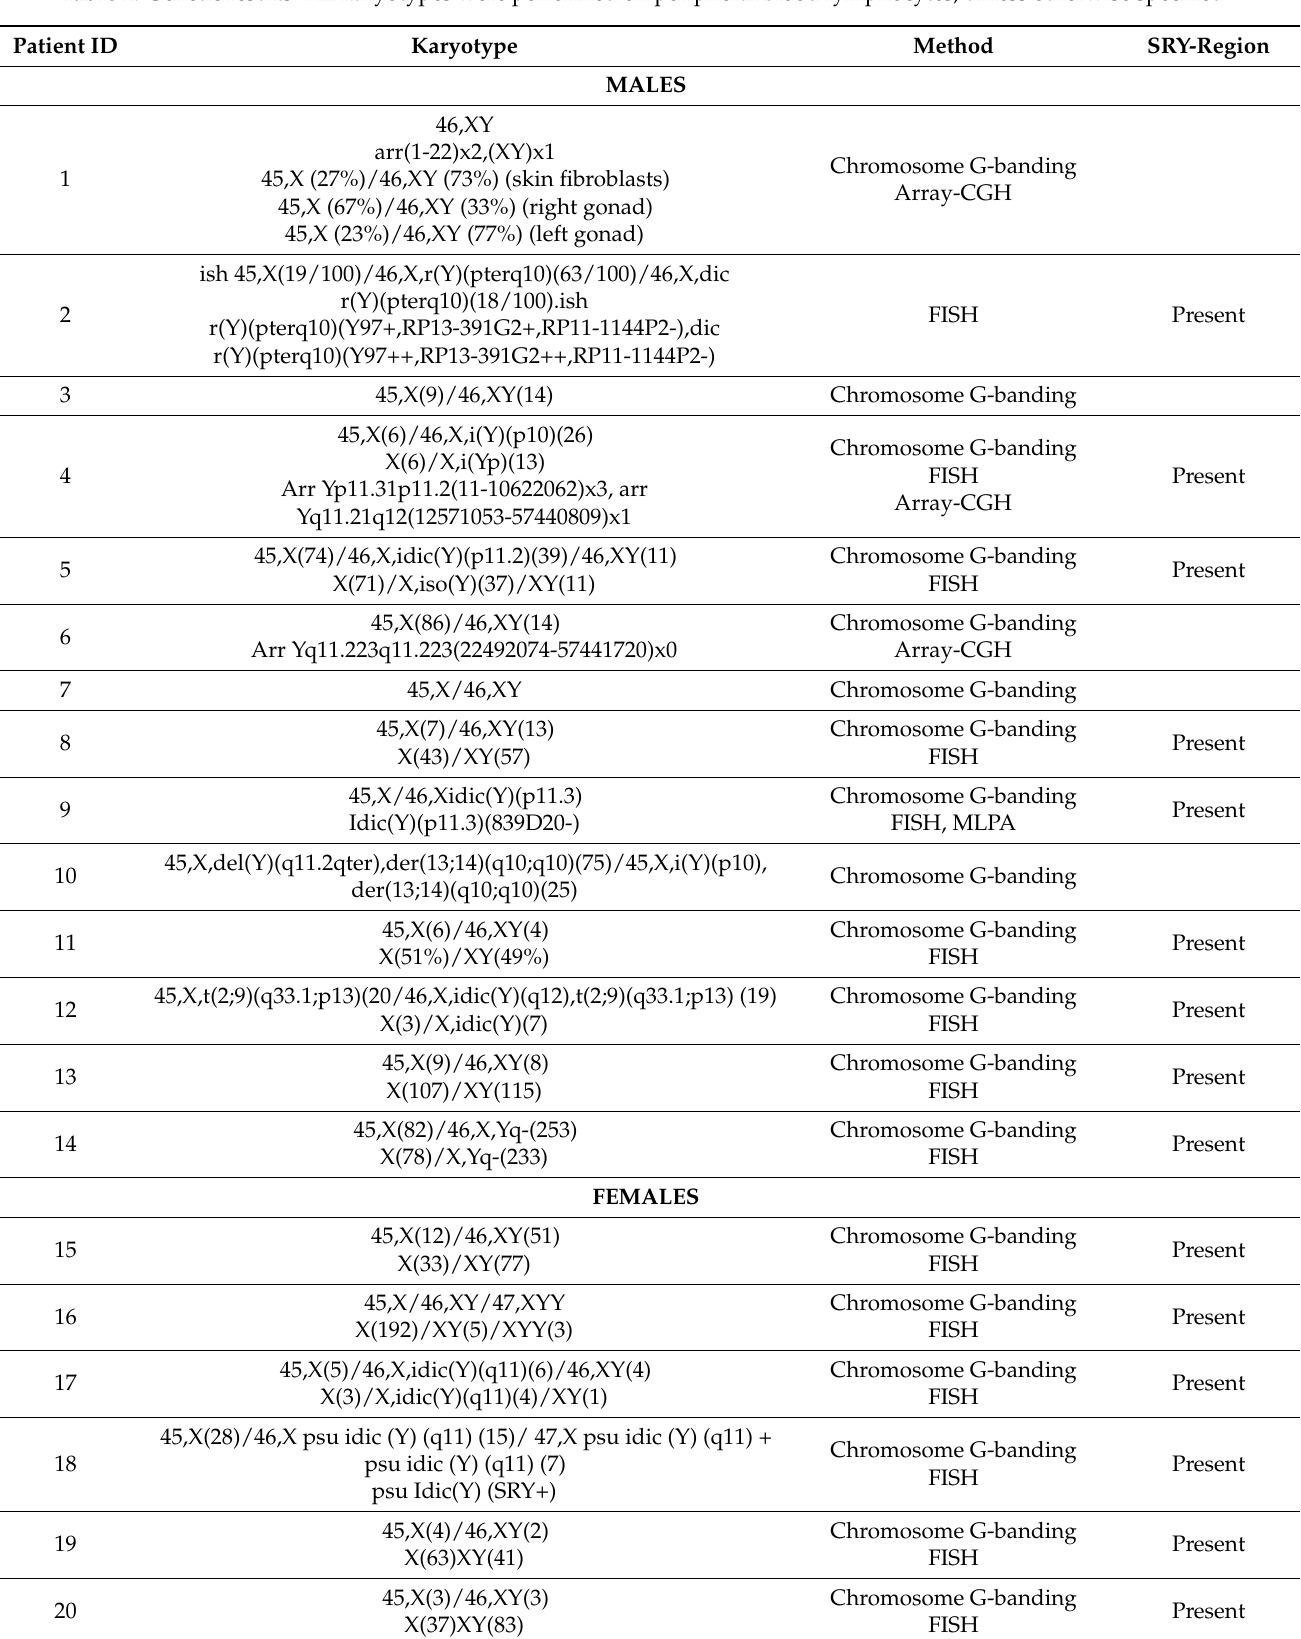
Table 2. Genetic results. All karyotypes were performed on peripheral blood lymphocytes, unless otherwise specified. Patient